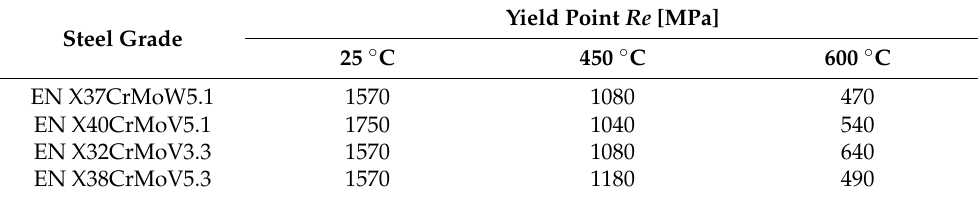
Table 1. The yield point of selected steel grades for hot work at 25, 450 and 600 ◦ C